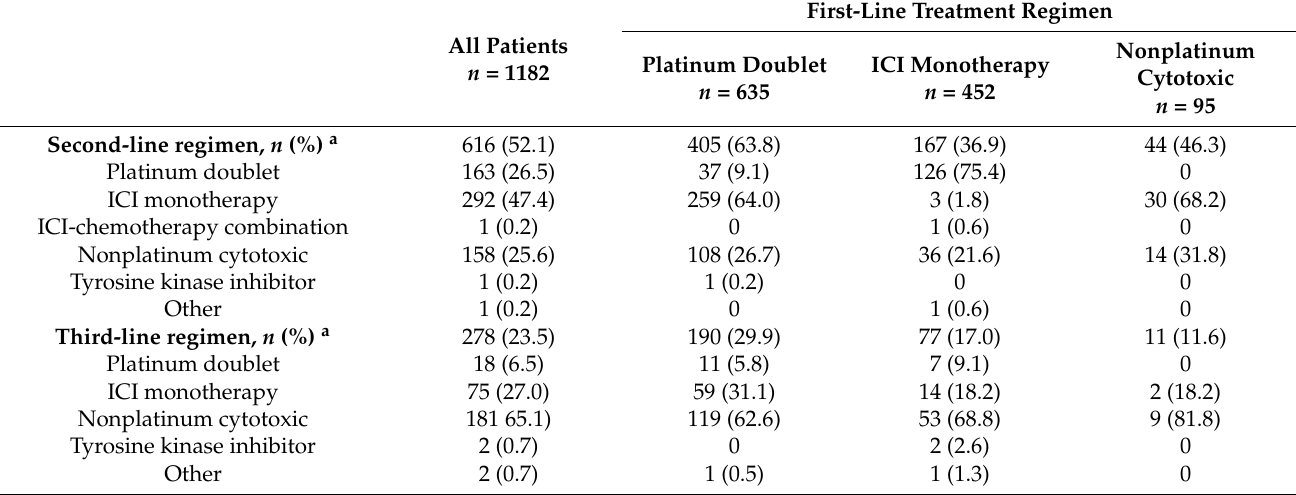
Table 3. Subsequent systemic therapy regimens by treatment